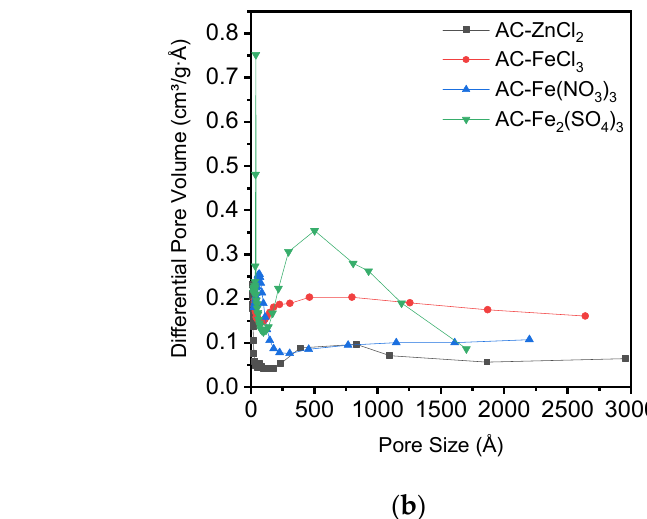
Figure 1. N 2 adsorption–desorption isotherms ( a ) and pore size distributions ( b ) of the activated carbon (AC) materials. Table 2. Textural properties of the carbon materials.